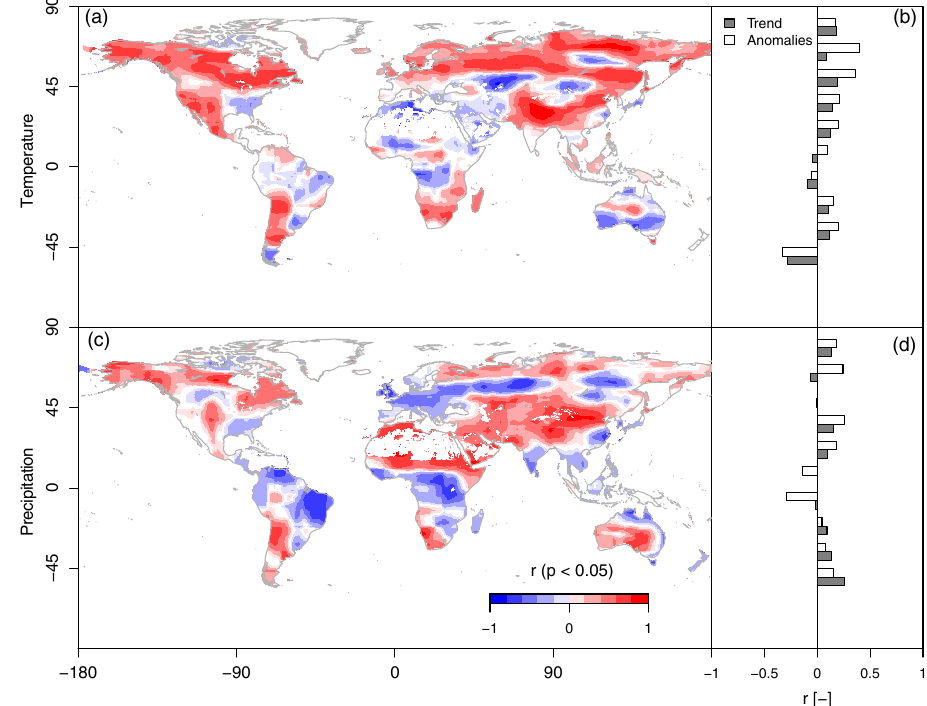
Figure 7. Climatic drivers of the spatial variability in NEE interannual variability. The panels (a) and (c) show maps of the spatial correlation coefficients (within moving spatial windows of 15 ◦ × 11 . 5 ◦ ) of interannual NEE amplitude versus time-mean temperature and precipitation for the bottom–up product MPI-MTE. Pixels with non-significant correlation are left white. The bar plots in (b) and (d) show latitudinal averages of the correlation coefficients of NEE trend and anomalies versus temperature and